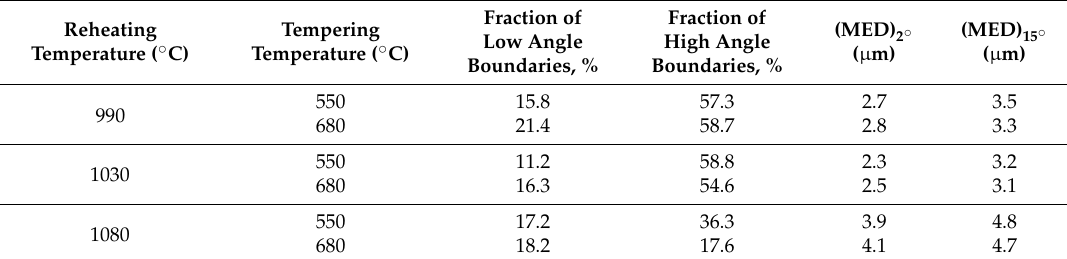
Figure 8. Inverse pole figure maps obtained from EBSD measurement of the specimens treated under different conditions: ( a ) RT = 990 °C, TT = 550 °C; ( b ) RT = 990 °C, TT = 680 °C; ( c ) RT = 1030 °C, TT = 550 °C; ( d ) RT = 1030 °C, TT = 680 °C; ( e ) RT = 1080 °C; TT = 550 °C; ( f ) RT = 1080 °C, TT = 680 °C (RT: reheating temperature; TT: tempering temperature). Table 3. EBSD results of the microstructural quanti fi cation.